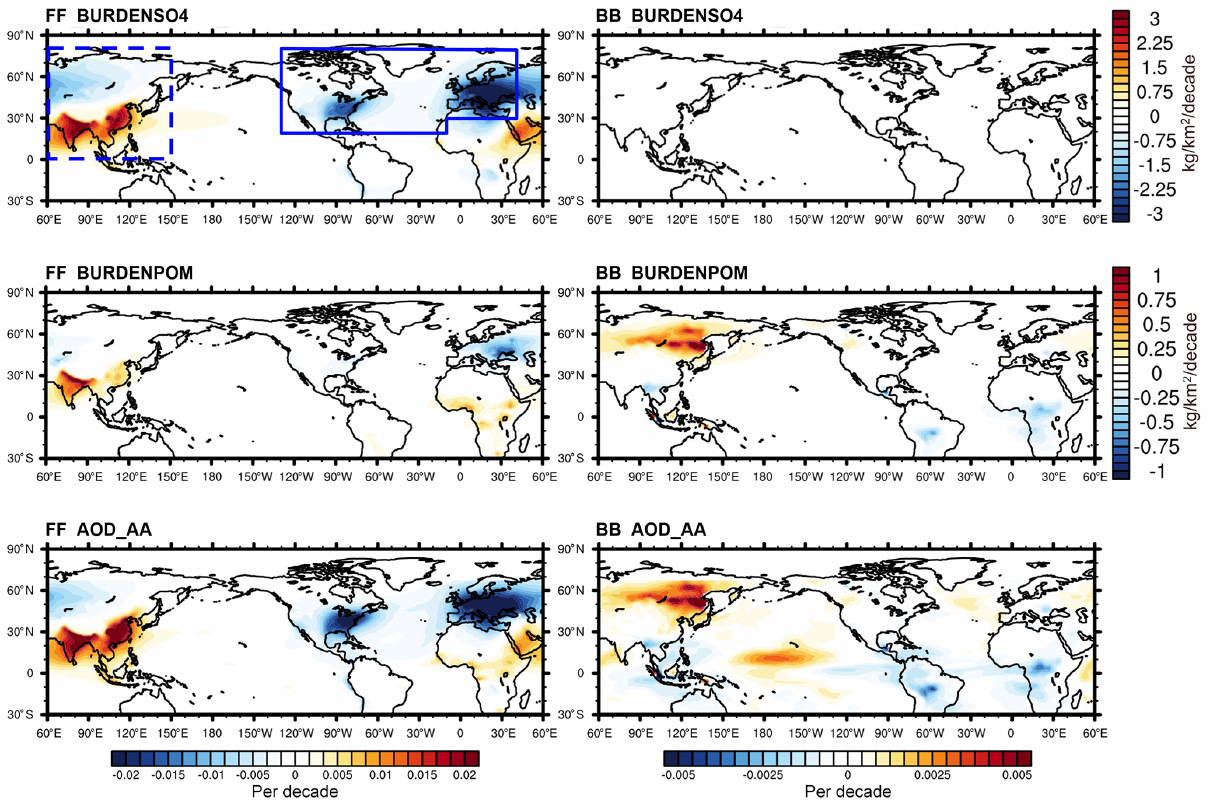
Figure 2. The first and second rows show the 40-year trend of the sulfate and primary OC (POM) column burden (kilograms per square kilometer per decade; hereafter kgkm − 2 per decade) in response to FF (left) from 1980 to 2020 and BB (right) emission changes. Black carbon (BC) and secondary organic aerosol (SOA) are not shown, but the patterns are very similar to SO 4 . The third row shows the 40- year trend of AOD-AA (aerosol optical depth due to anthropogenic aerosols). Note that the color scale of FF is twice that of BB. The blue dashed box in the upper left panel indicates the Eastern Hemisphere box (EH box; 0–80 ◦ N, 60–150 ◦ E) used for the regional fixed-aerosol simulations. The solid box indicates the Western Hemisphere box (WH box; 20–80 ◦ N, 130–10 ◦ W, and 30–80 ◦ N, 10 ◦ W–40 ◦ E).